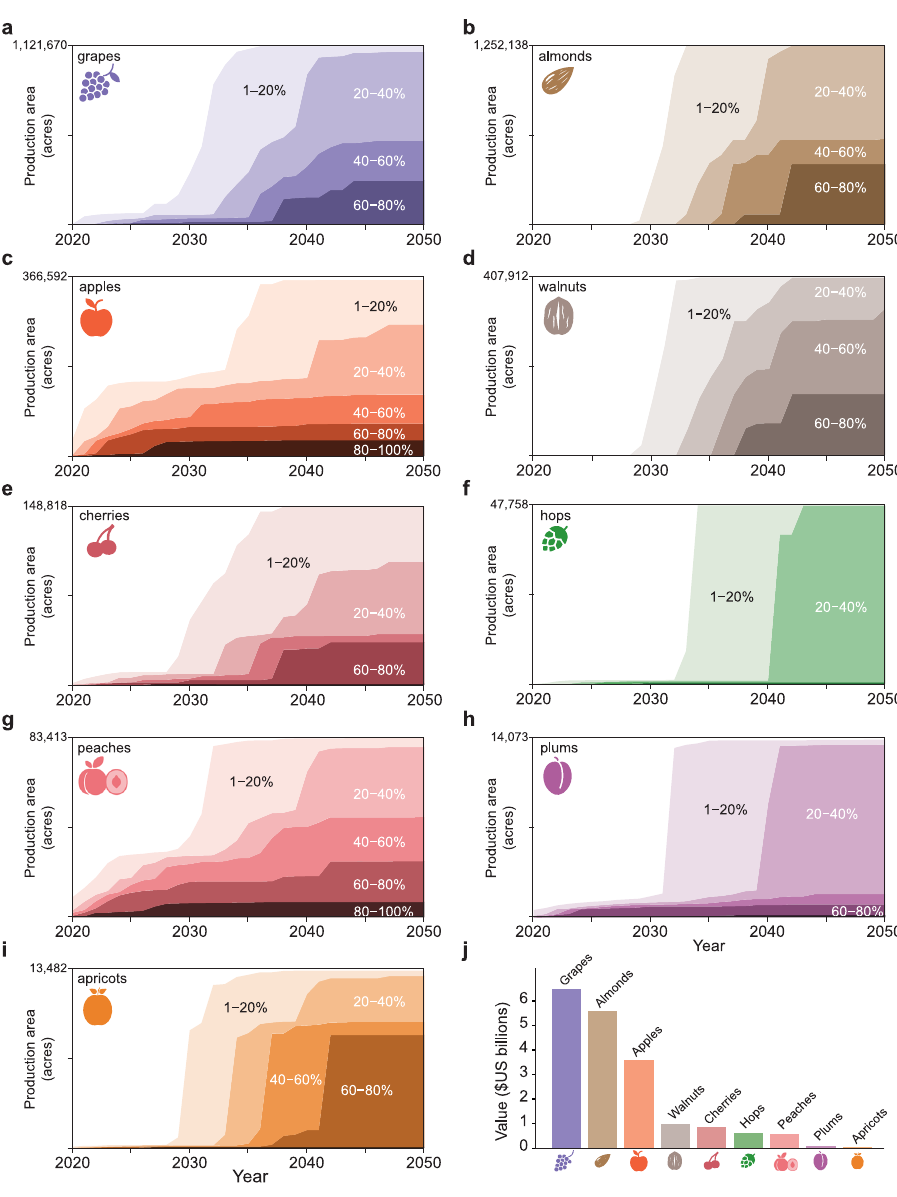
Fig. 2 Crops at risk from SLF and total value. a – i Probability of SLF establishment over time for major crops. j The economic value of each crop. All acreage and economic data are from the USDA National Agricultural Statistics Service 2017 census 10